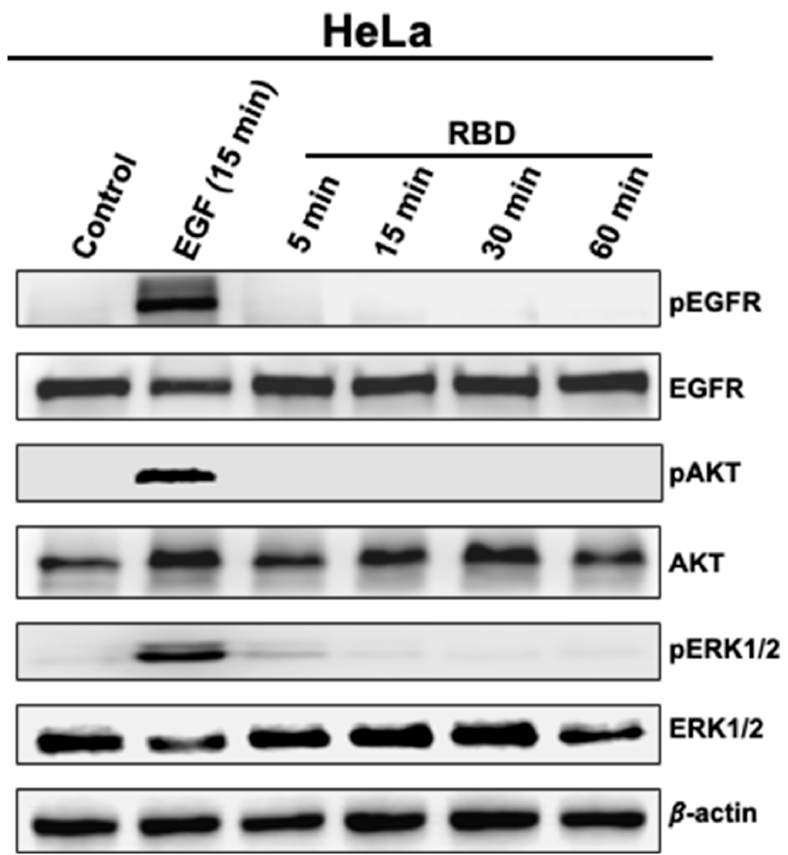
Figure 4. Time-course accumulation of pEGFR, pAKT, and pERK1/2 in RBD-treated HeLa cells. HeLa cells were treated or not with 5 µg/mL RBD protein for the indicated time points (5, 15, 30 and 60 min), and the protein levels of pEGFR, pAKT and pERK1/2, and their respective total levels were determined by western blot. As a positive control, the treatment with EGF (5 µg/mL) was carried out for 15 min.